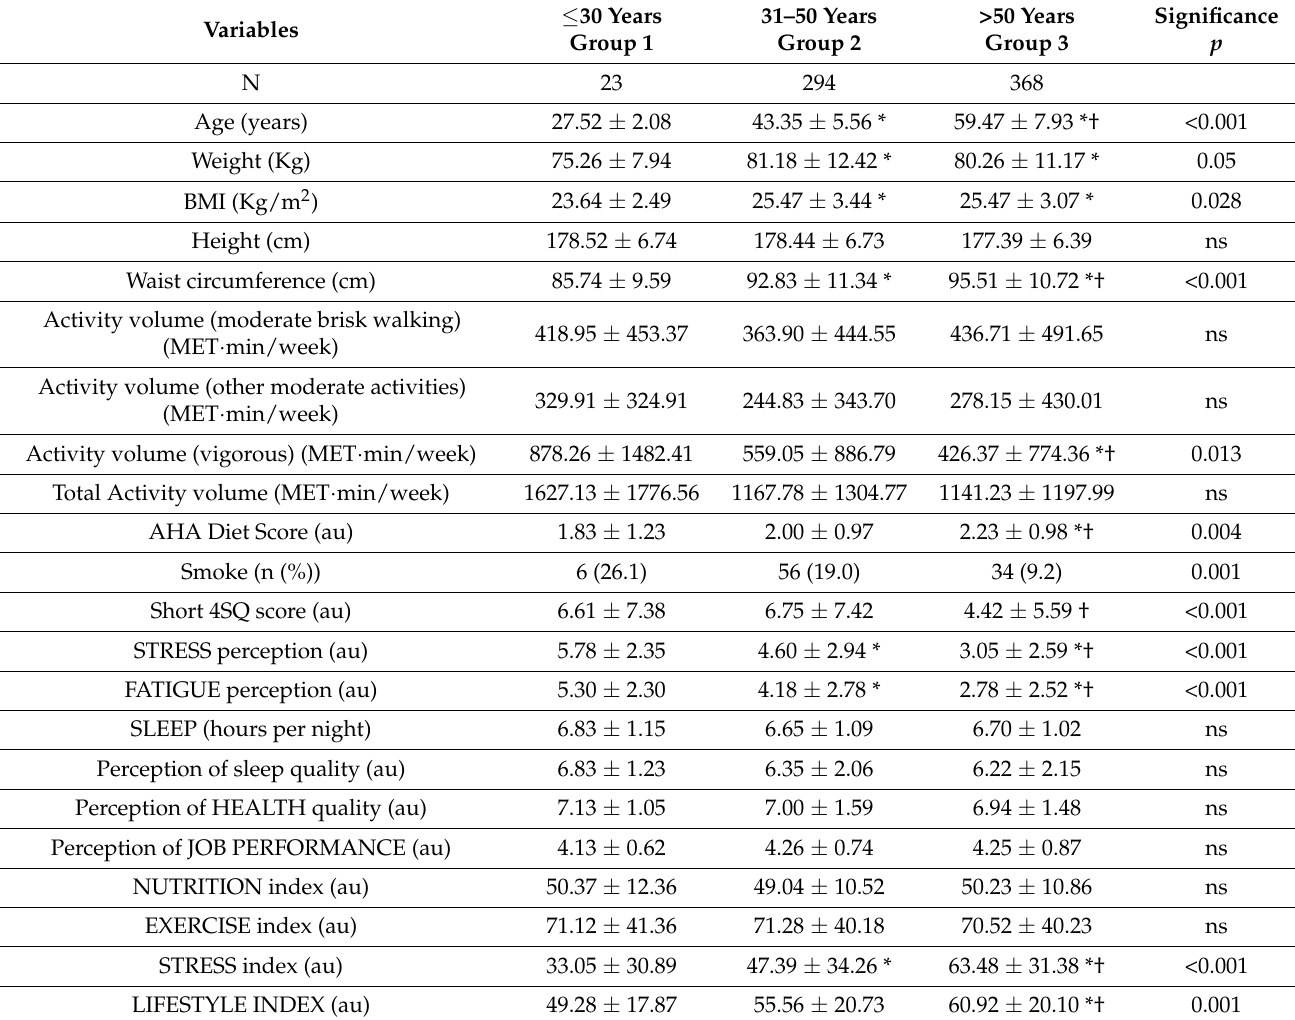
Table 3. Anthropometric and lifestyle data were collected in male individuals, by separately consid- ering the three age